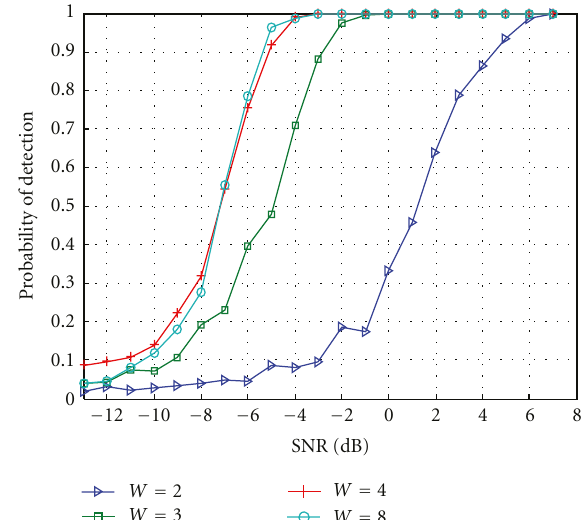
Figure 5: Influence of T c /T e ( N = 64, D = 16, U = 5, N b = 2).